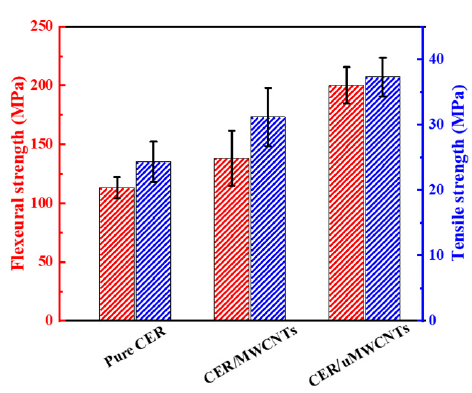
Figure 6. The mechanical properties of pure CER network, CER/MWCNTs and CER/uMWCNTs nanocomposites.